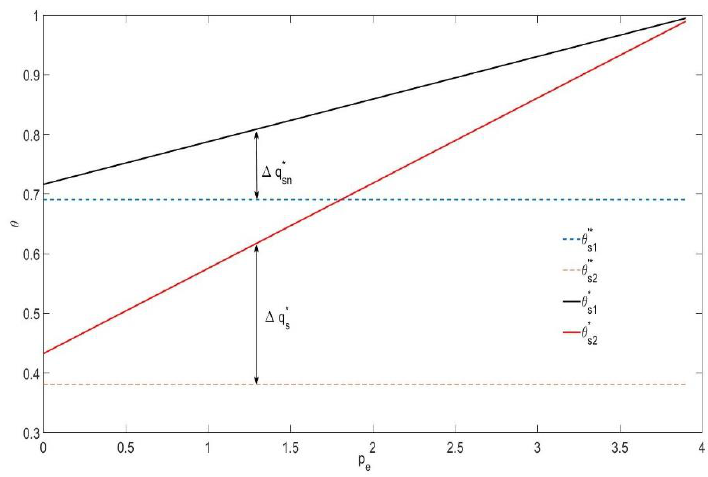
Figure 4. The effect of p e on the utility type of consumers under a selling strategy ( λ 2 = 0.2 ).